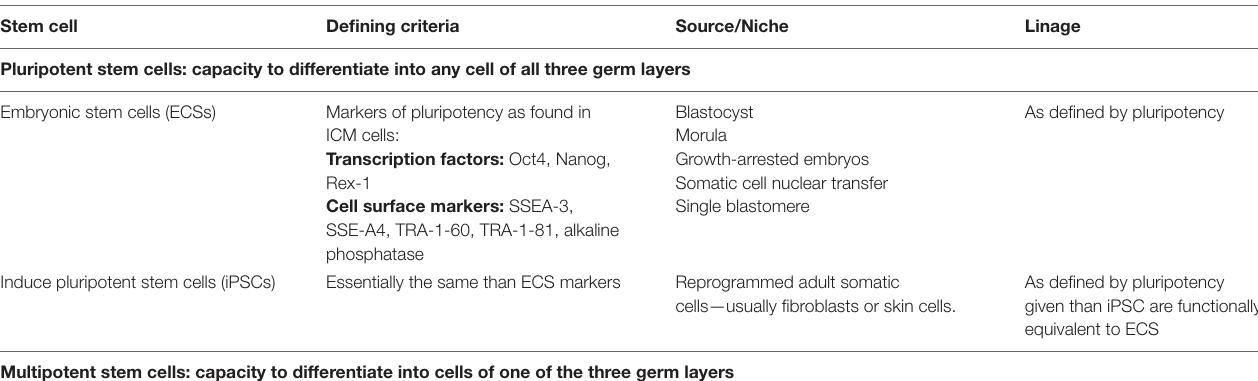
TABLE 1 | Classification and major features of stem cells reported in glioma